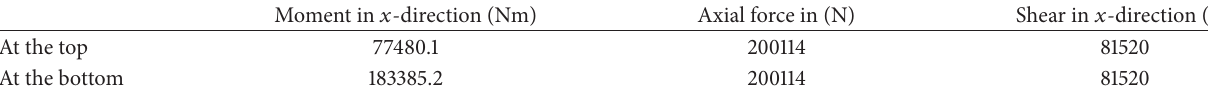
Table 4: Maximum (envelope) internal forces of a column due to earthquake loading.